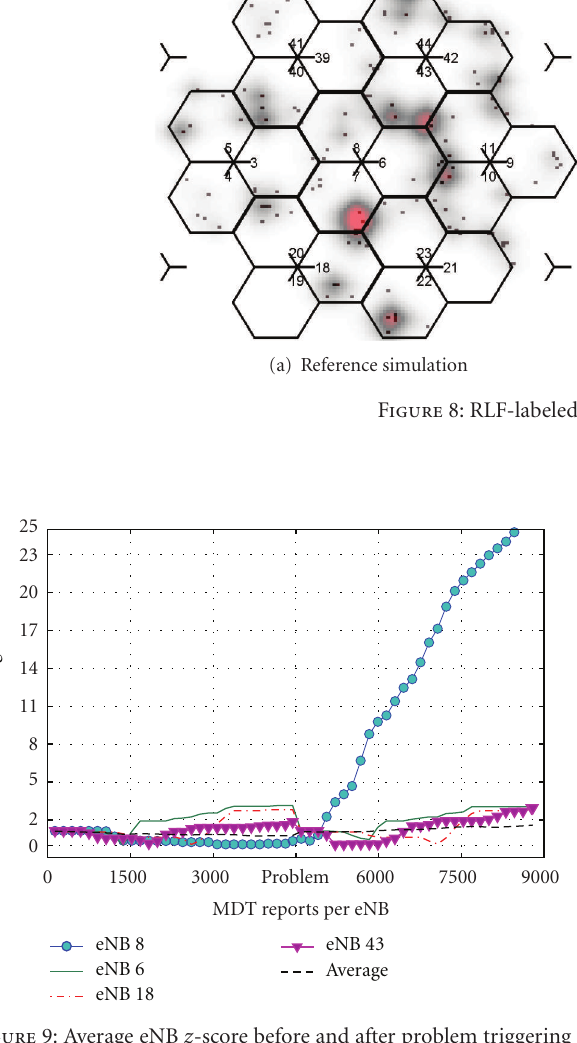
Figure 9: Average eNB z -score before and after problem triggering in eNB